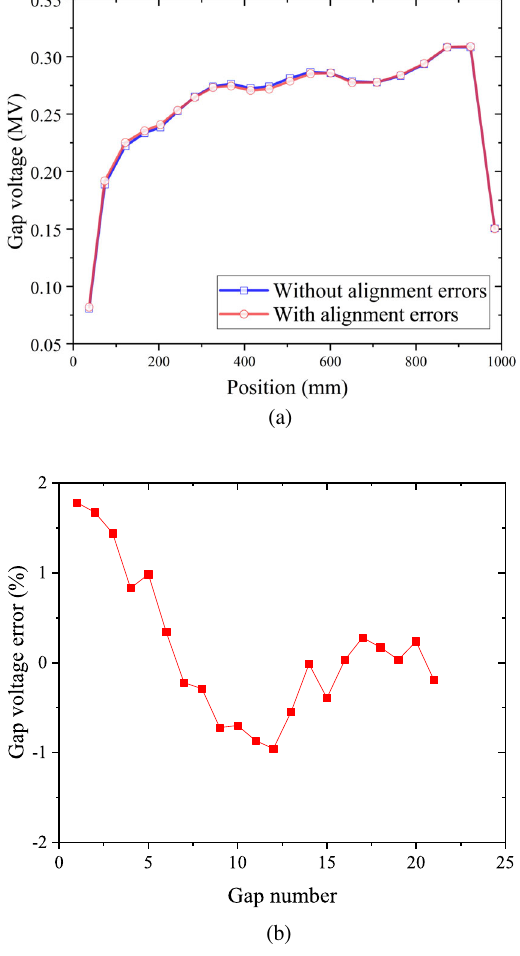
FIG. 5. (a) Calculated gap voltage distribution along the beam axis. (b) Gap voltage